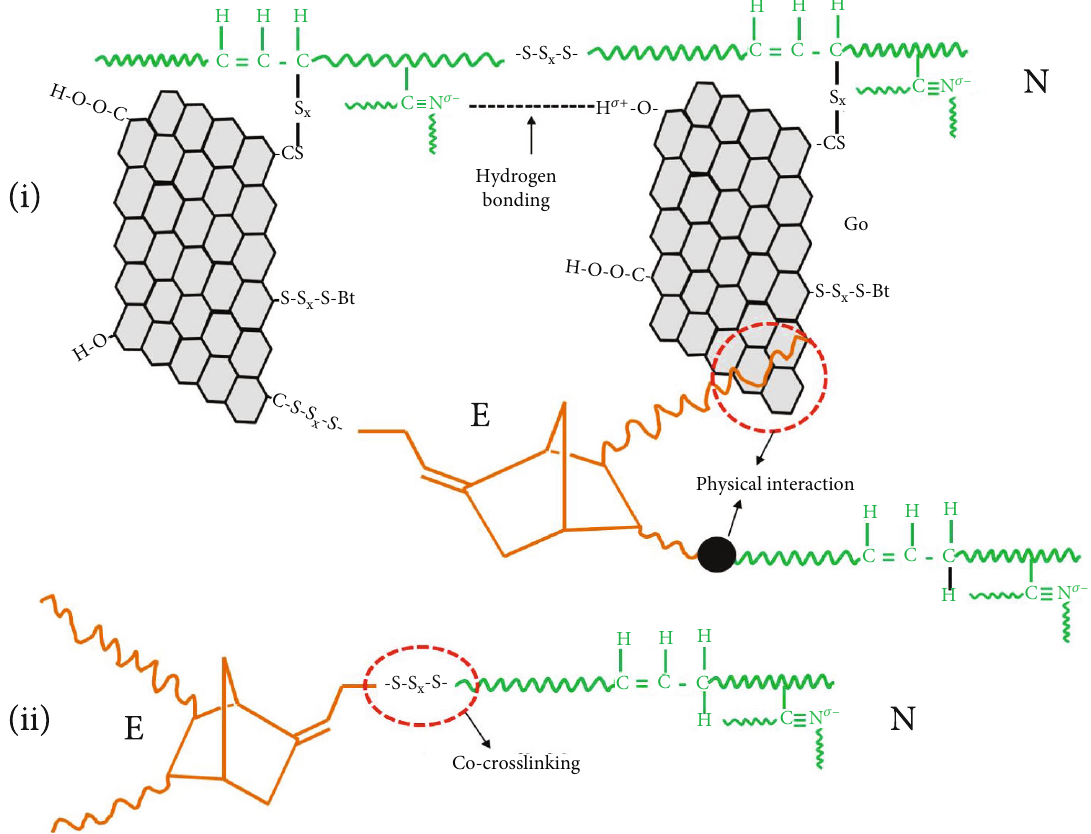
Figure 6: Interactions of GO and G sheets with N and E matrices during vulcanization; (i) reaction of GO/G fi llers, N, and E matrices and (ii) cocrosslinking between N and E.